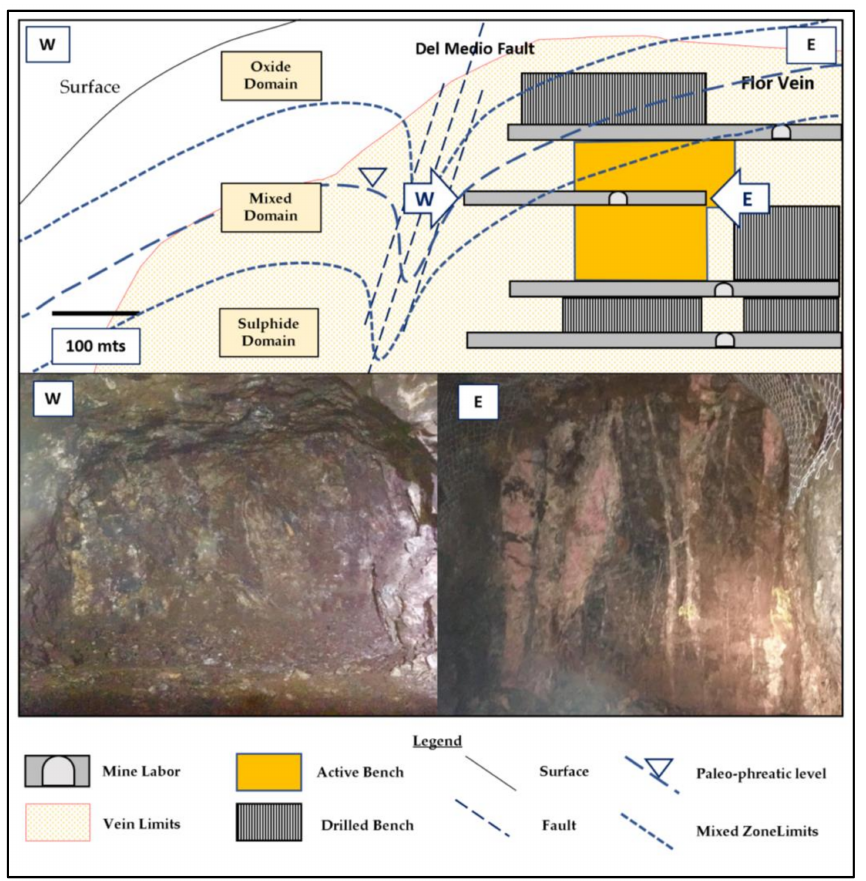
Figure 3. Flor vein workfaces, 975 level, Florida Mine. A difference in the oxidation state of the ore is observed within the same vein and level. The west workface is partially or completely oxidized compared to the east workface where the sulphides are